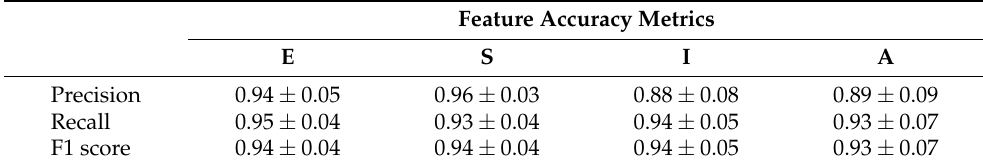
Table 1. Prediction performance of stream boundary detection for the different features: elevation (E), slope (S), intensity (I), and flow accumulation (A) within one standard